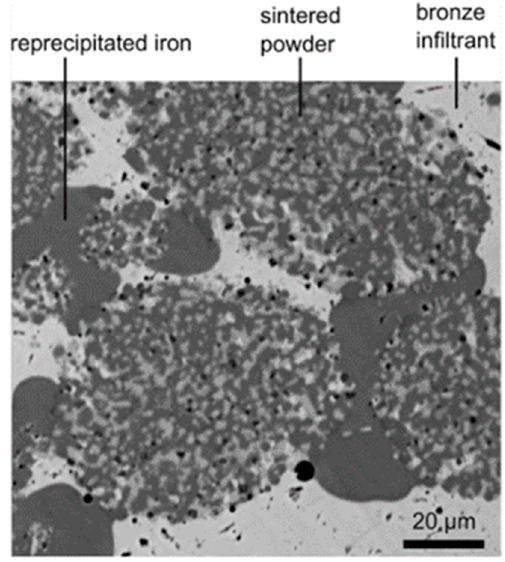
Figure 13. Backscatter electron micrograph of the infiltrated ferrous material with bronze infiltrant [105] .